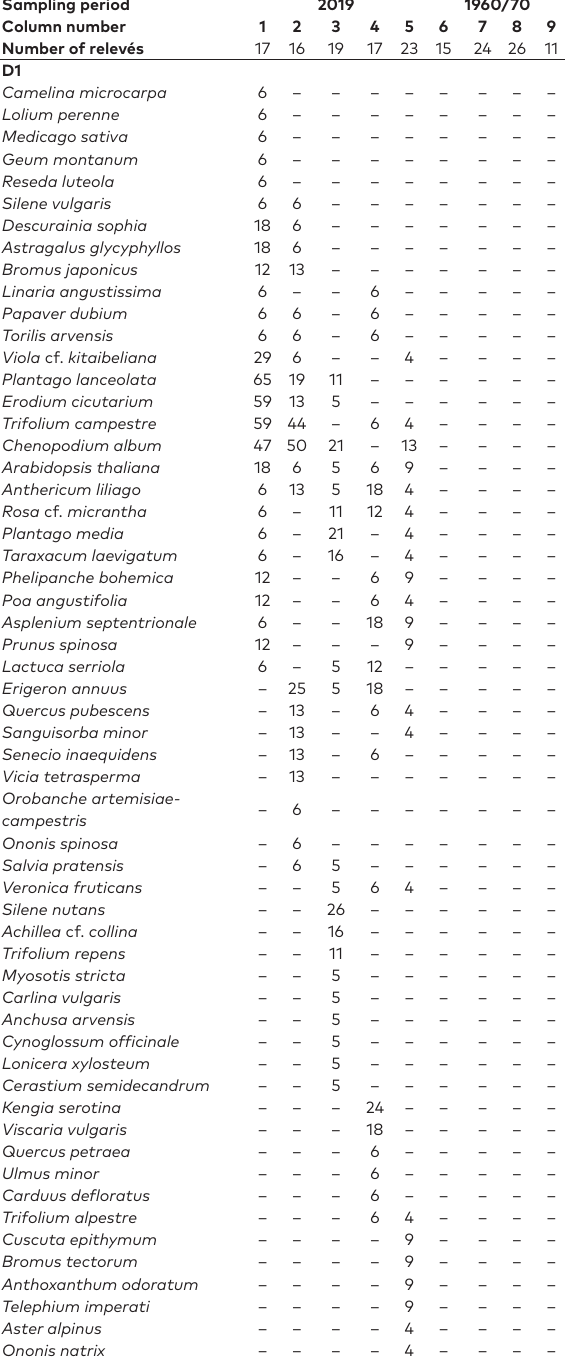
Table 2. Synoptic table of the dry grassland communities in the Vinschgau (South Tyrol, Italy) from 2019 in comparison to the 1960s/´70s. Values are percentage frequencies. The columns 1 to 9 show the different relevé groups based on the similarity of the species (2019, cols. 1-5; 1960s/70s, cols. 6–9). Different species groups (D1 – D5) were identified which sep- arate the new and old relevés. The floristical shift over time is illustrated by these groups. In D5 species are stated which do not show a clear change over time in their frequencies. Only species with frequency > 15% are stated in this group. Abbre- viations: agg. = aggregate, cf. = confer (means “compare”),